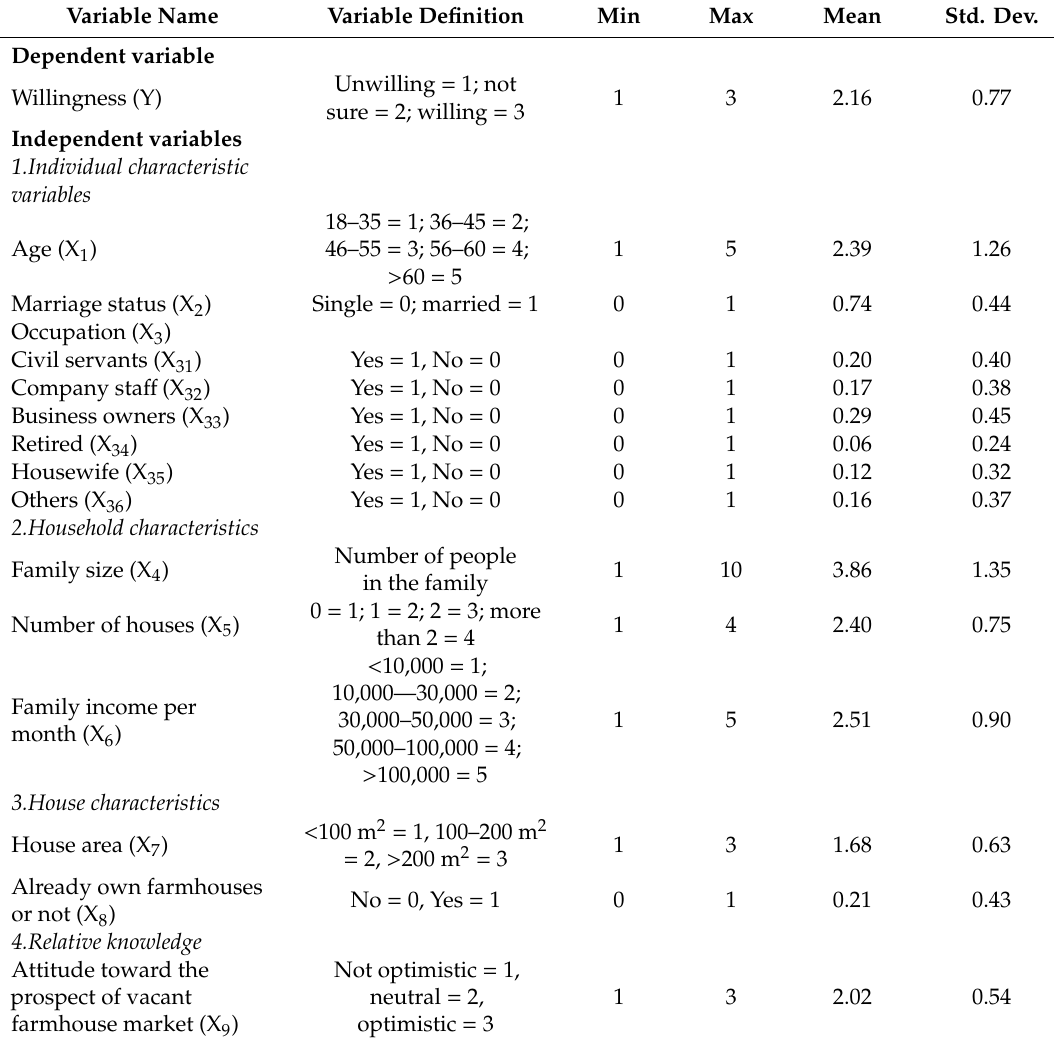
Table A2. Variable description and statistical features of urban residents.